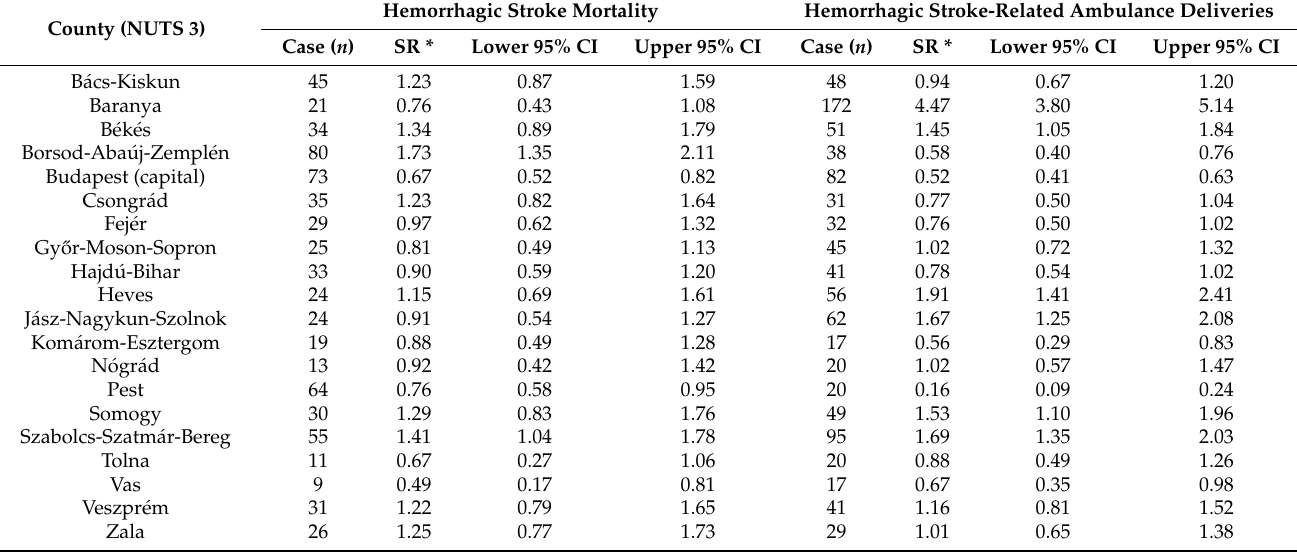
Table 3. Hemorrhagic stroke mortality and hemorrhagic stroke-related ambulance deliveries in Hungary,